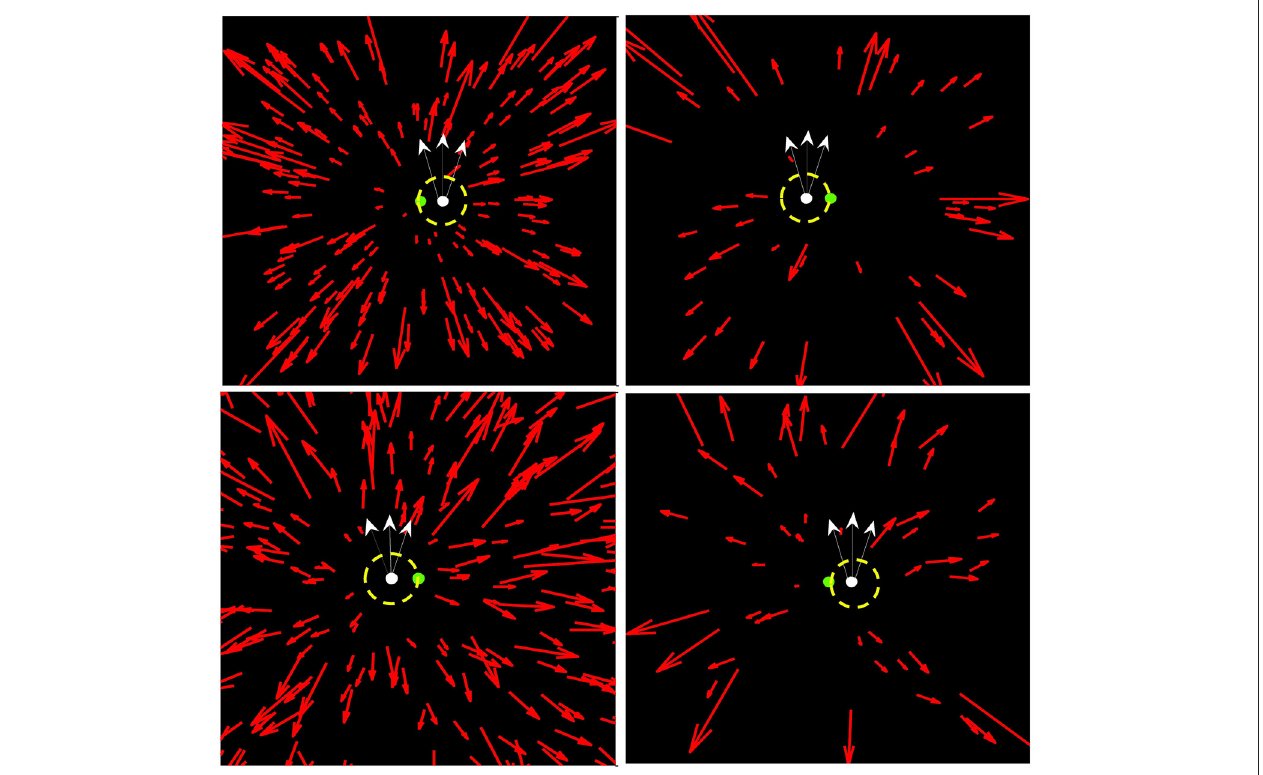
three possible directions starting at one of two locations. The dashed circle is a 3 ◦ aperture which the radial flow dots could not enter. This minimized the contribution of local motion processing